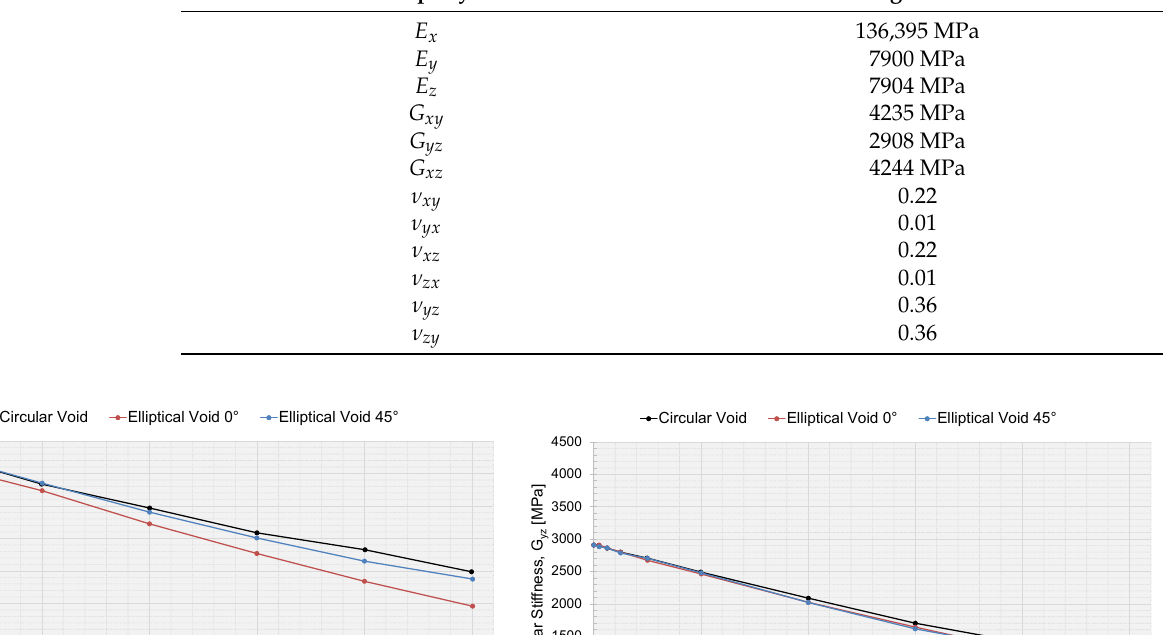
Table 5. Average effective macromechanical properties for an RVE without a void. Property